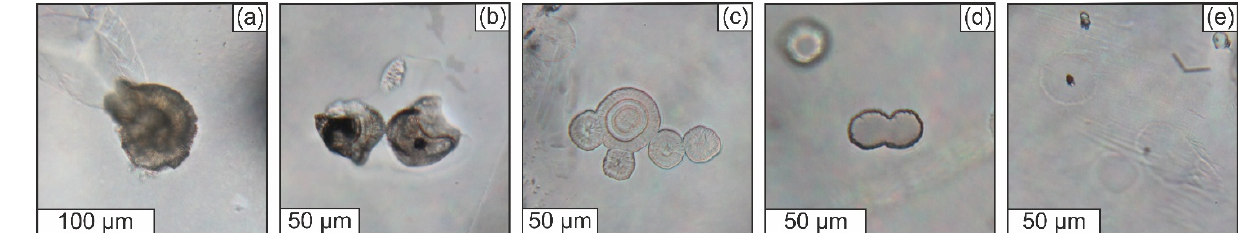
Figure 6. Transmitted light images of spherulites in chalcedony ( a ) and quartz ( b – e ). Note that spherulites in quartz range from almost identical to those in chalcedony, such as the ones in ( b ), to very faint and barely visible, such as the ones in ( e ) and in the top left corner in ( c ).